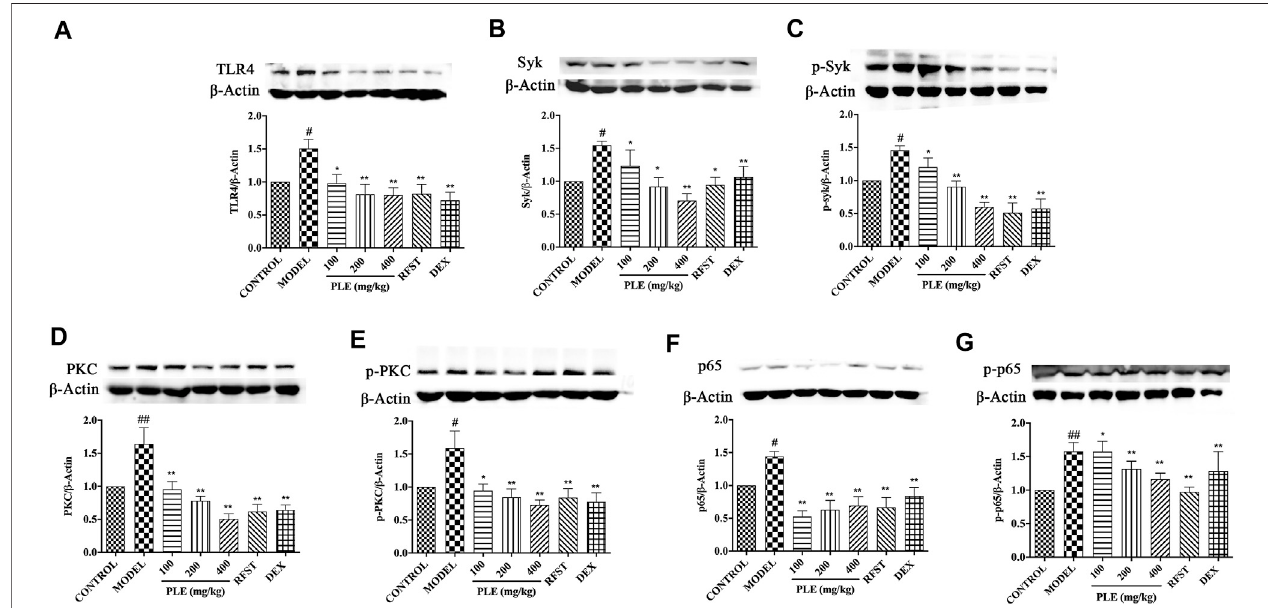
FIGURE4| EffectsofthePLEontheproteinexpressionsofTLR4 (A) ,Syk (B) ,p-Syk (C) ,PKC (D) ,p-PKC (E) ,NF- κ Bp65 (F) ,andp-NF- κ Bp65 (G) inlungtissues of COPD mice (n (cid:2) 5). Data were shown as mean ± SEM; # p < 0.05 and ## p < 0.01 compared with the CONTROL group; * p < 0.05 and ** p < 0.01 compared with the MODEL group.